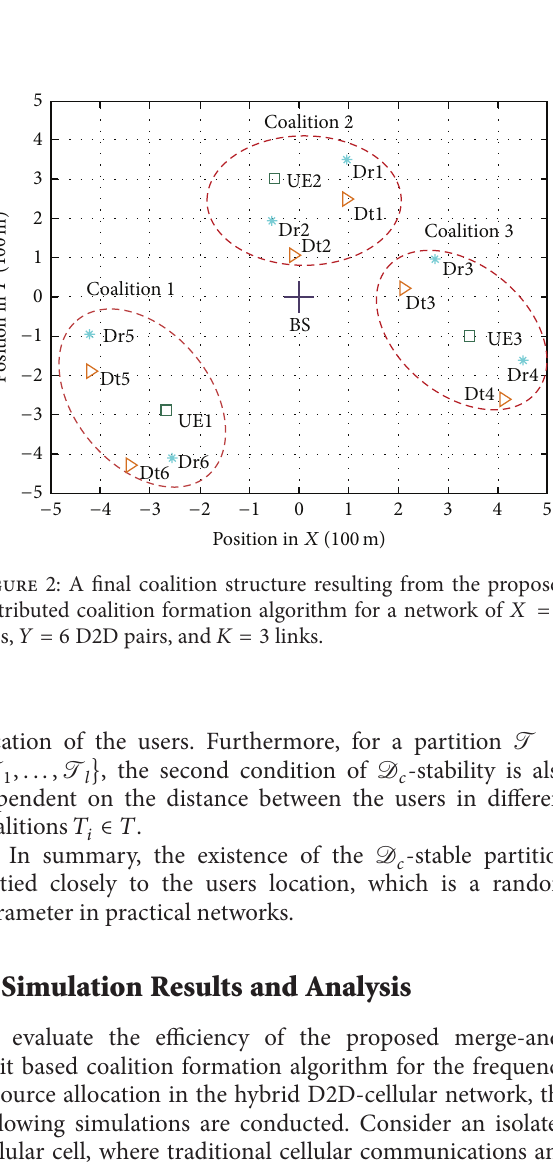
Figure 3: Comparison in terms of network sum rate between different